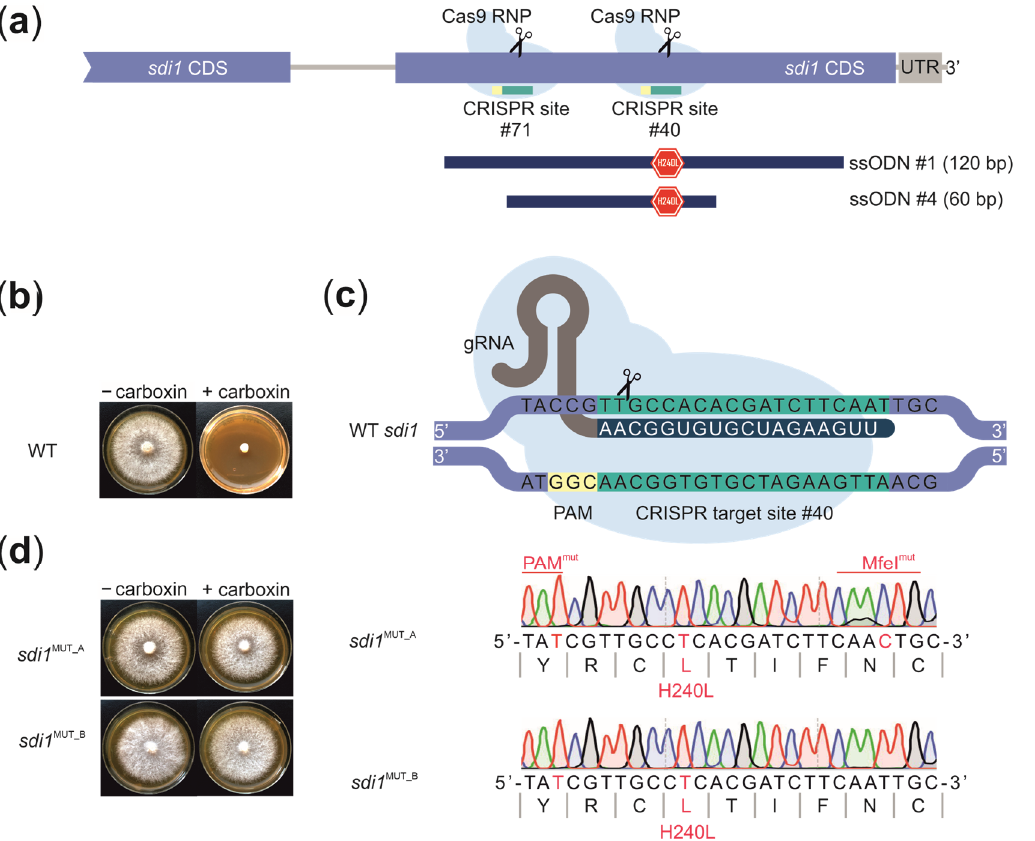
Figure 3. ( a ) Two ssODN donors with varying length were designed to create a missense mutation H240L in the last exon of the D. squalens sdi1 gene. ( b ) The wild-type D. squalens (WT) is sensitive to fungicide carboxin. ( c ) Schematic representation of the Cas9 target site in the D. squalens sdi1 gene; the missense and nonsense mutations introduced by Cas9-mediated homologous recombination at the sdi1 locus are shown. ( d ) The sdi1 H240L mutants are carboxin resistant.